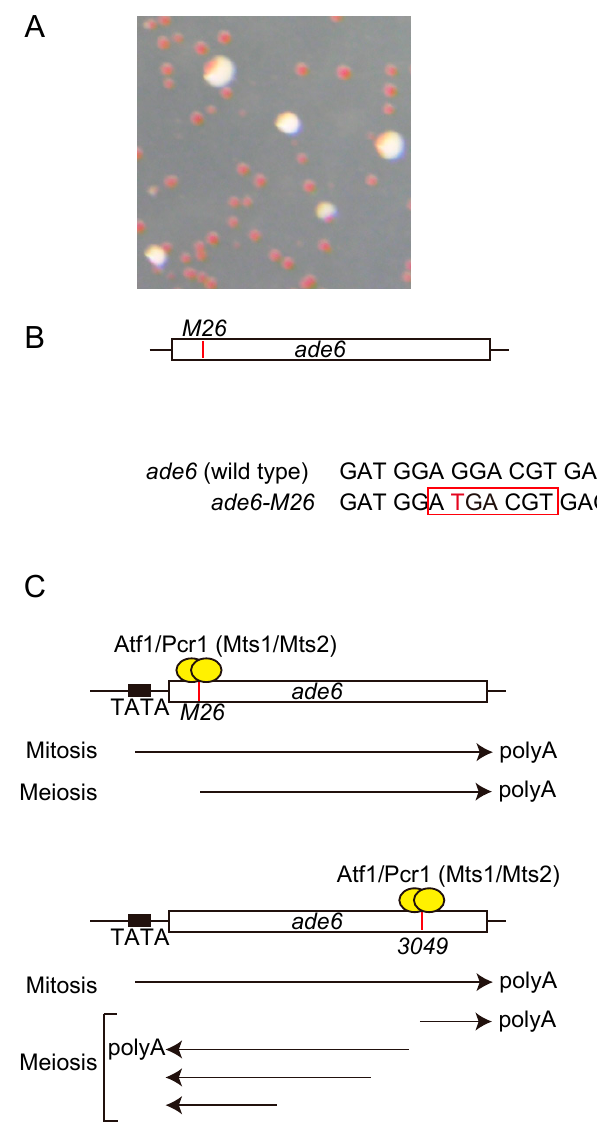
Figure 2. ade6-M26 meiotic recombination hotspot created by single nucleotide substitution. ( A ) Im- age of pink colonies on a medium containing limited adenine concentration. ( B ) Schematic repre- sentation of ade6-M26 allele. The white box shows ade6 gene. The red vertical line shows the M26 mutation point. The sequences around M26 mutation are indicated. The red letter indicates the sin- gle nucleotide substitution in the ade6-M26 allele. The red square shows cyclic adenosine mono- phosphate (cAMP)-responsive element (CRE)-like heptanucleotide sequence. ( C ) Schematic repre- sentation of ade6-M26 and ade6-3049 alleles. White boxes show ade6 gene. Red vertical lines show each mutation. Yellow circles show Atf1 and Pcr1 (Mst1 and Mts2) transcription factors. Arrows indicate transcripts. In mitosis, ade6-M26 and ade6-3049 strains express ade6 gene from TATA box, while the transcriptional initiation site was shifted to Atf1/Pcr1 binding sites in meiosis. 3. Transcription Factor Required for Meiotic Recombination at M26 The M26 -mutation is a nonsense mutation that creates a cyclic adenosine monophos- phate (cAMP)-responsive element (CRE)-like heptanucleotide sequence 5 ′ -ATGACGT-3 ′ (Figure 2B, Red square). Later, biding factors to this CRE-like heptanucleotide sequence was identified and named as Mst1 and Mst2 and it was revealed that these bind factors activate meiotic recombination [48–50] (Figure 2C). After this identification, three groups almost simultaneously identified Atf1, a basic leucine zipper (bZIP) transcription factor that is activated by the mitogen-activated protein kinase (MAPK) pathway [51–53]. More- over, a similar bZIP protein, Pcr1, was also identified [54], and Mts1 and Mts2 were found to be identical to Atf1 and Pcr1, respectively [48]. In fission yeast, meiosis is induced by